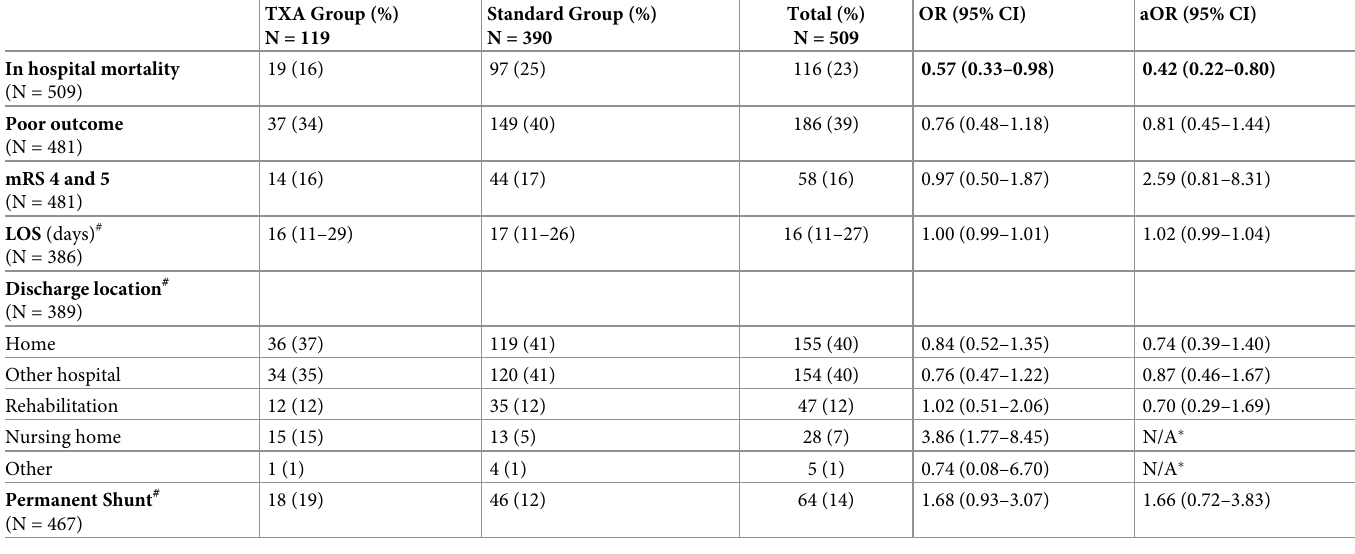
Table 3. Patient outcome by treatmentgroup and adjusted per center with or without TXA